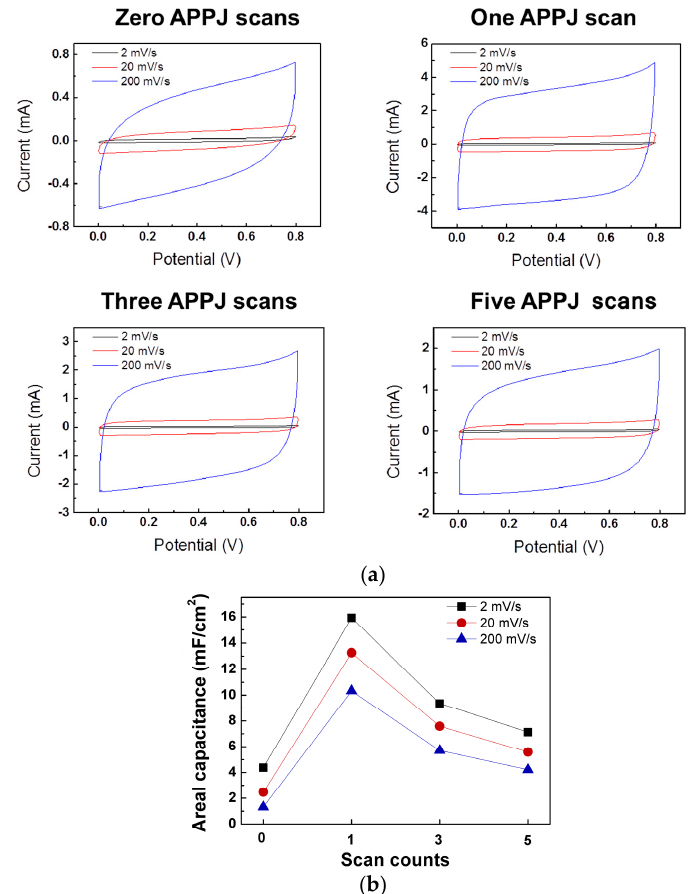
Figure 7. ( a ) CV results of gel-electrolyte supercapacitors made with rGO pastes on carbon cloth processed by scan-mode APPJ; ( b ) Comparison of areal capacitance calculated from CV results in Figure